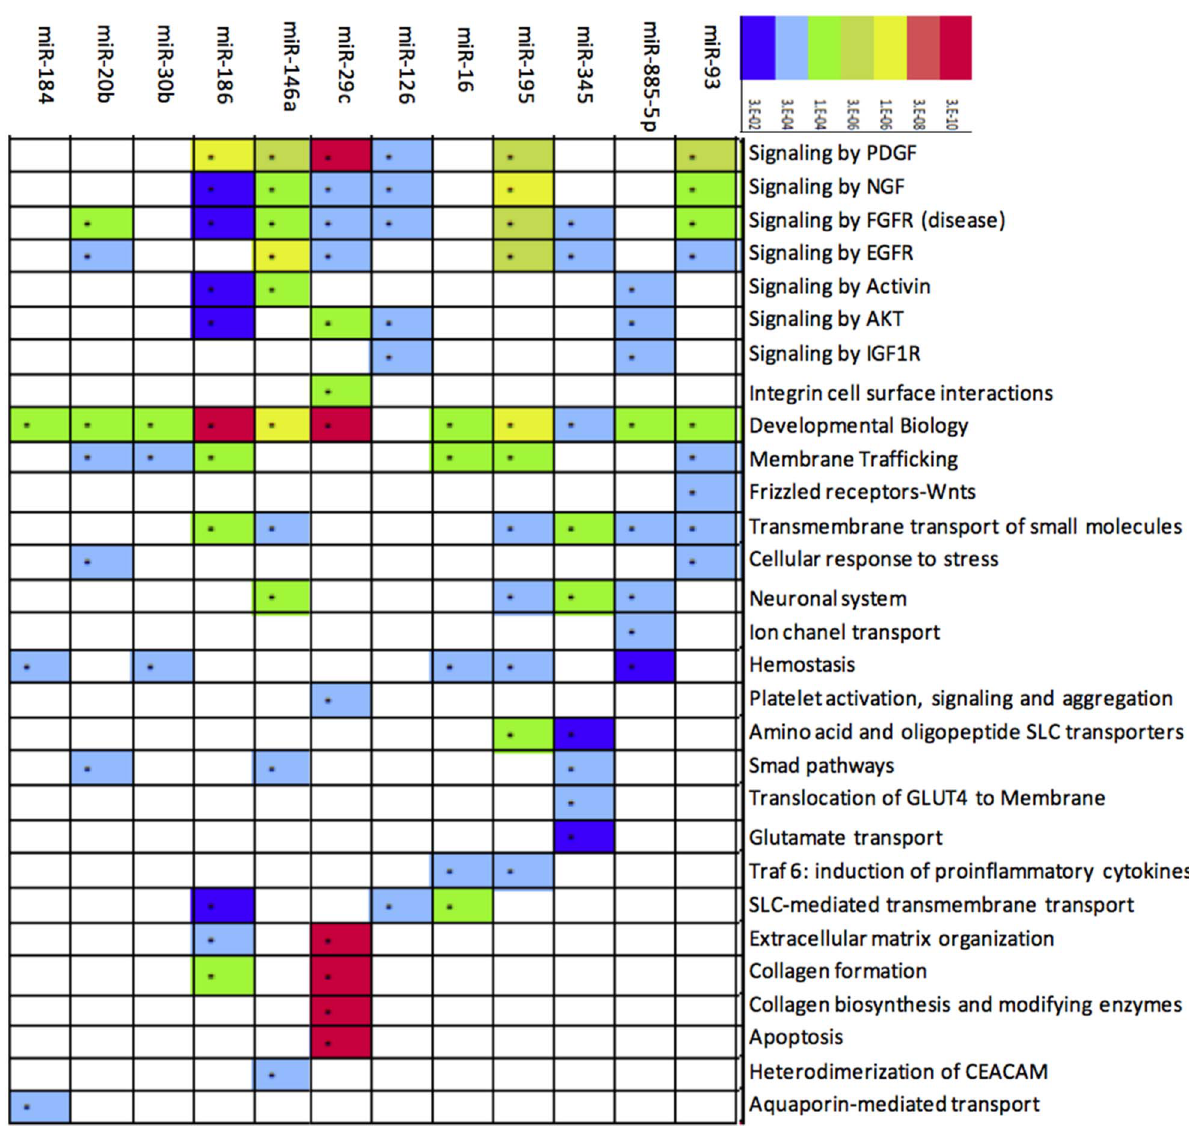
Figure 3. Pathways associated with microRNA (miRNA) up-regulated in Osteoarthritis (OA). Enriched biological processes among the 12 up-regulated miRNA. Red shows the e-value as more significant, while less significance is denoted in blue.